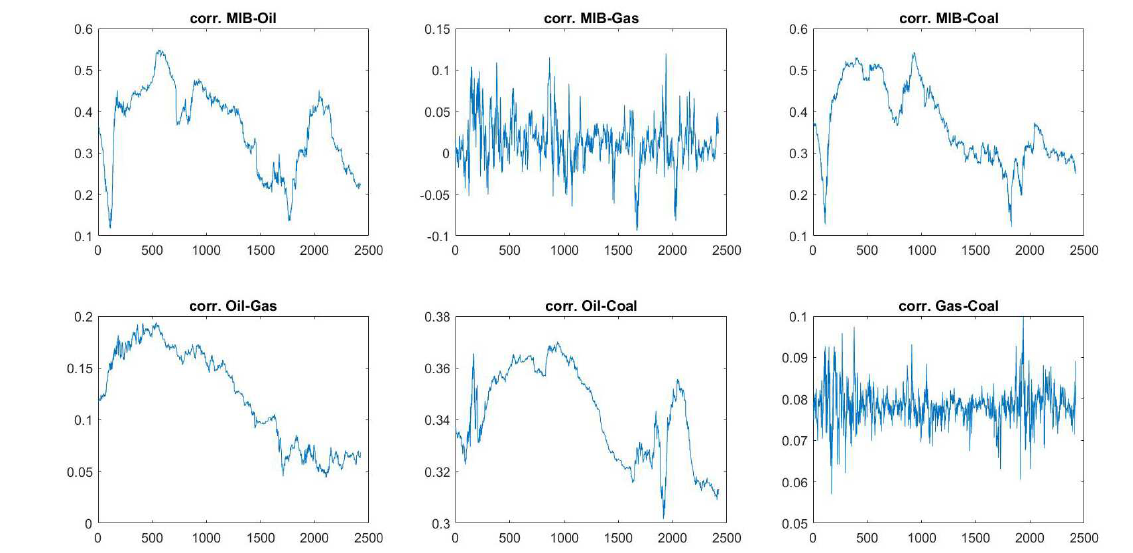
Figure 3. Dynamic correlation between each pair of variables (following DCC